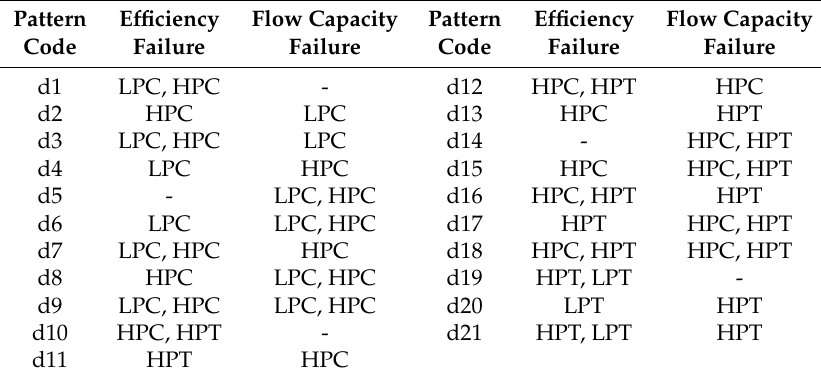
Table 11. Failure patterns of concurrent component failure.